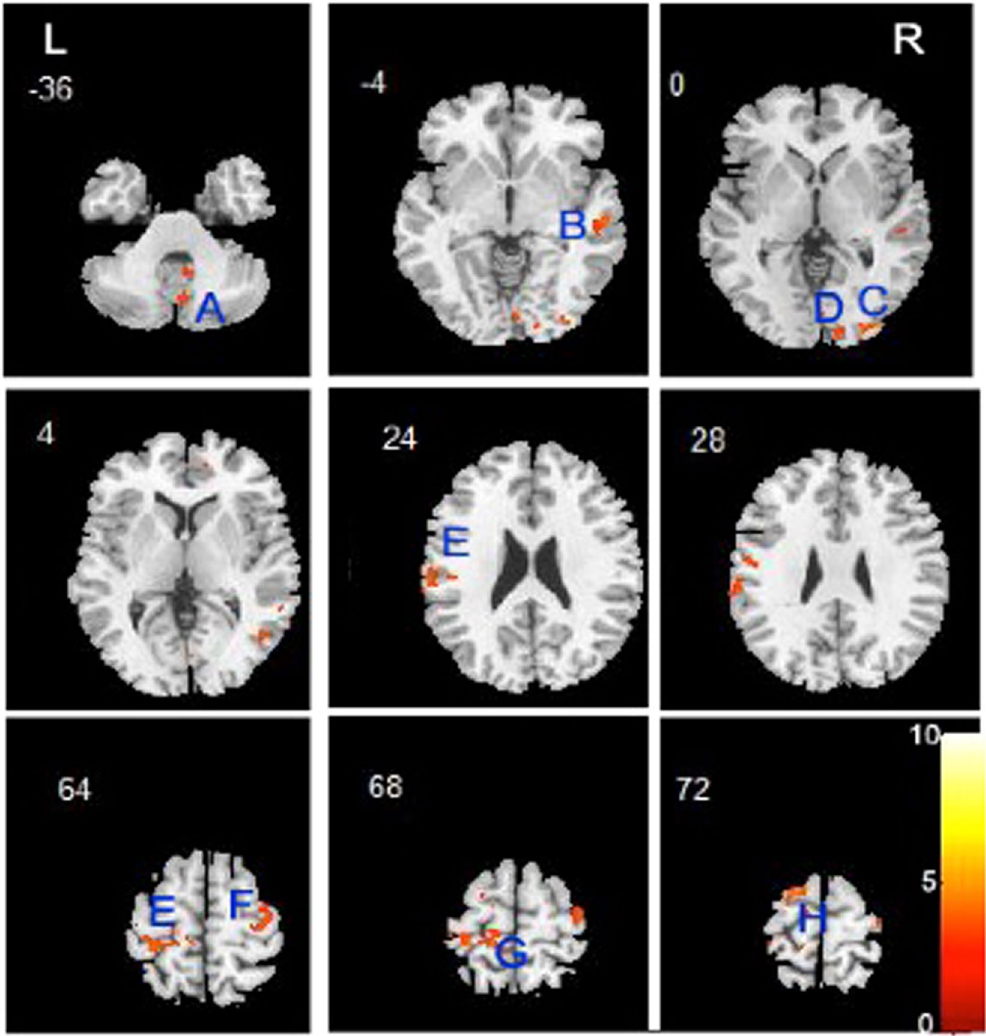
Figure 1. Relative to healthy comparison subjects, patients with drug-naïve, first-episode schizophrenia showed significantly reduced gray matter volume. ( A ) Right cerebellum posterior pyramis; ( B ) Right middle temporal gyrus; ( C ) Right middle occipital gyrus; ( D ) Right occipital cuneus gyrus; ( E ) Left parietal postcentral gyrus; ( F ). Right frontal precentral gyrus ( G ) Left frontal precentral gyrus; ( H ) Left superior frontal